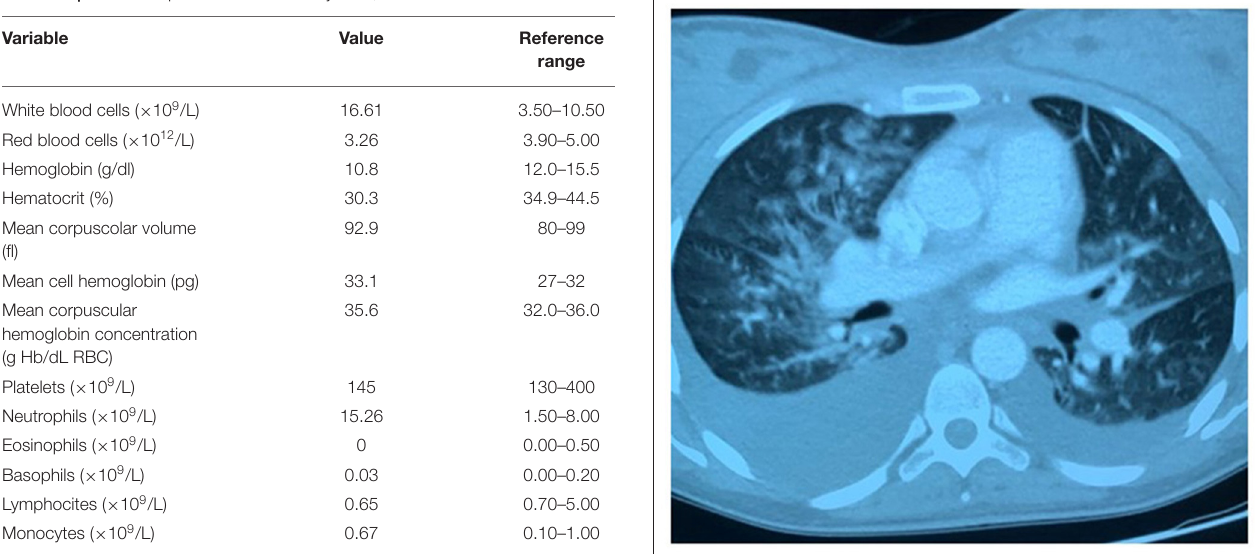
TABLE 1 | Blood test performed on January 25th, 2020.